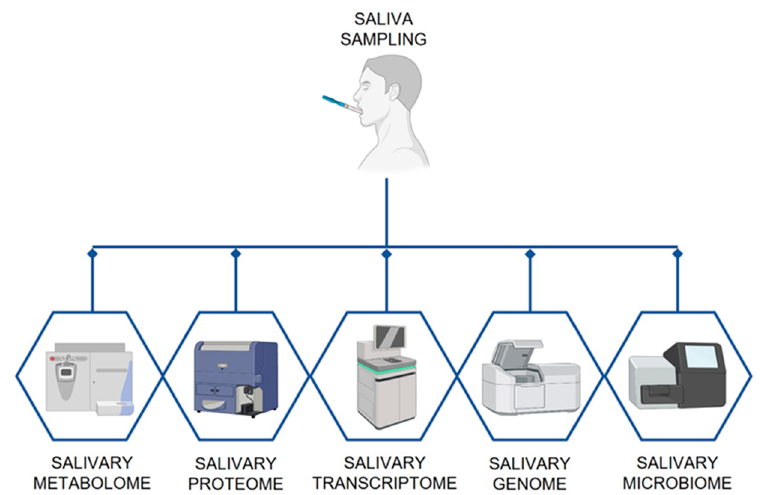
Figure 3. The subfields of salivaomics.